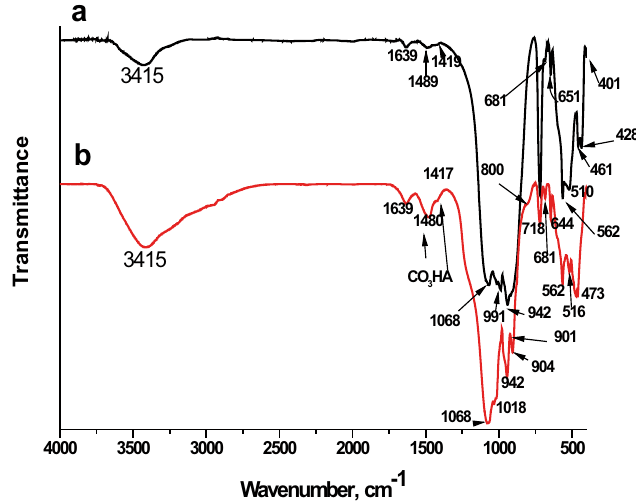
Figure 2. FTIR spectra of CPS/W thermal treated at 1200°C/2 h (a) and after immersion in TRIS-HCl buffer for 3 days